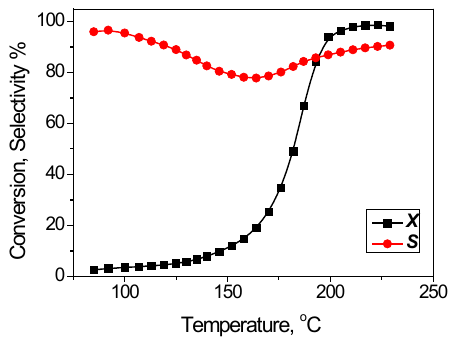
Figure 4. FA decomposition on 8% Ni-2.5% Mo/Sibunit catalyst after pretreatment in FA at 300 °C for 1 h.